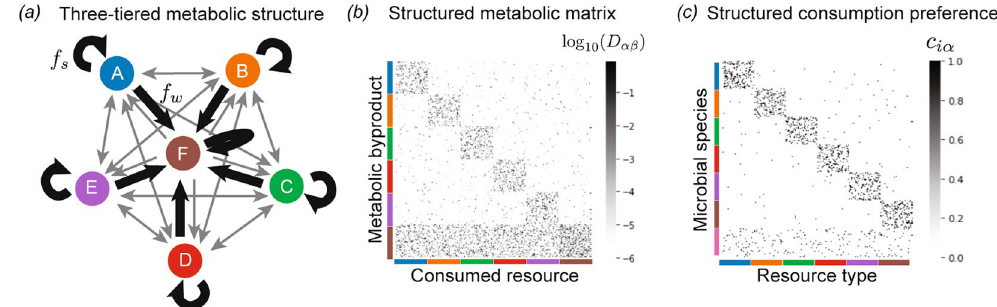
Figure 4. Incorporating metabolic and taxonomic structure. ( a ) Three-tiered secretion model used for simulating human and marine microbiomes. M = 300 resource types are grouped into T = 6 classes of equal size, labeled A through F. These groups represent different kinds of metabolites, e.g. lipids, sugars, amino acids, etc. Group F is the “waste” class, containing common byproducts generated by many metabolic pathways, e.g., carboxylic acids. A fraction f s of the byproduct flux from metabolism of a given resource is partitioned among resources of the same class. A fraction f w of the flux is partitioned among “waste” resources (class F). The rest of the flux is nonspecifically partitioned among all the other classes. In all simulations shown here, f s = f w = 0.45. ( b ) Heatmap of a metabolic matrix D αβ encoding the three-tiered secretion model. ( c ) Taxonomic structure used for human and marine microbiome simulations. Microbial species are grouped into “families,” with each family specializing in a different resource class. Specialist families allocate a fraction q of their consumption capacity to their favored resource class. In all the simulations shown here, q = 0.9. There is also a generalist family whose preferences are uniformly sampled across all resource